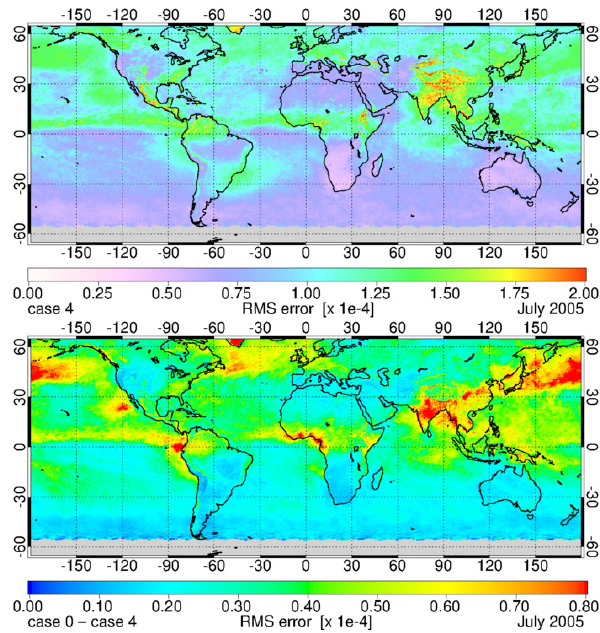
Figure 14. Monthly average gridded updated (case 4; top panel) Fig.14. Monthlyaveragegriddedupdated(case4;toppanel)RMSerrordataforJuly2005andthecorrespond- ingdifferencewiththecurrent(case0)data(lowerpanel). RMS error data for July 2005 and the corresponding difference with the current (case 0) data (lower